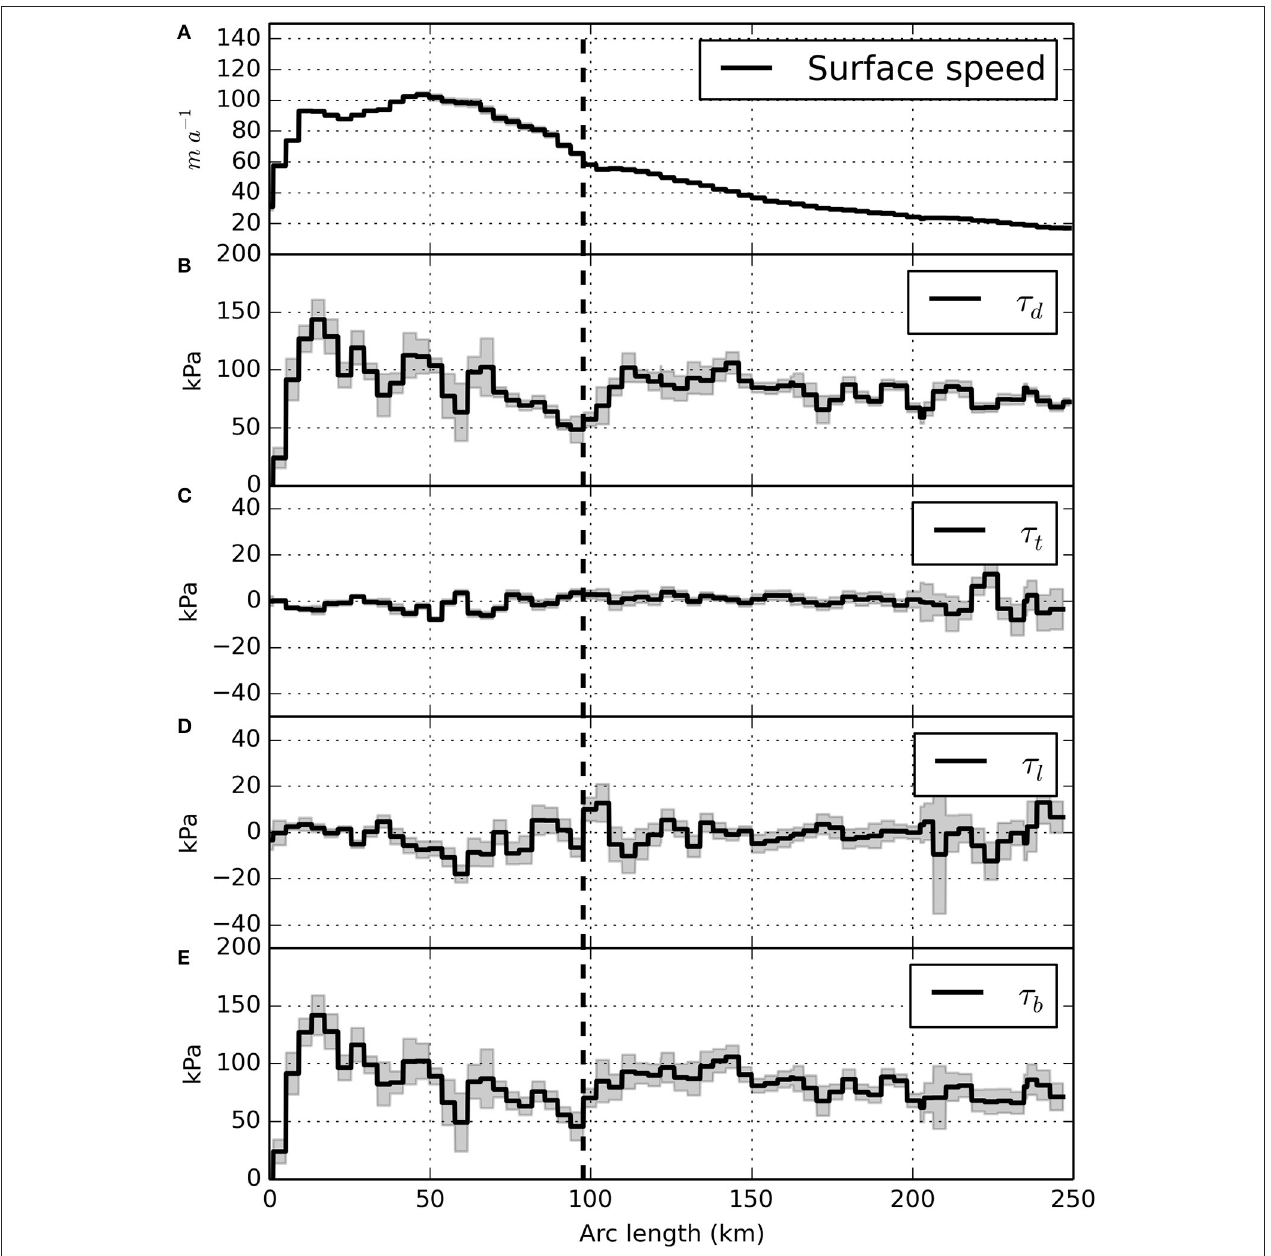
FIGURE 8 | Force balance calculation results along the flowline presenting driving stress (B), lateral drag (C), longitudinal stress gradient (D), and basal drag (E). Surface speed is presented in (A) for reference. Shaded regions represent the computed uncertainty for each force balance component. Dashed black line locates the approximate long term ELA (1553m elevation) for